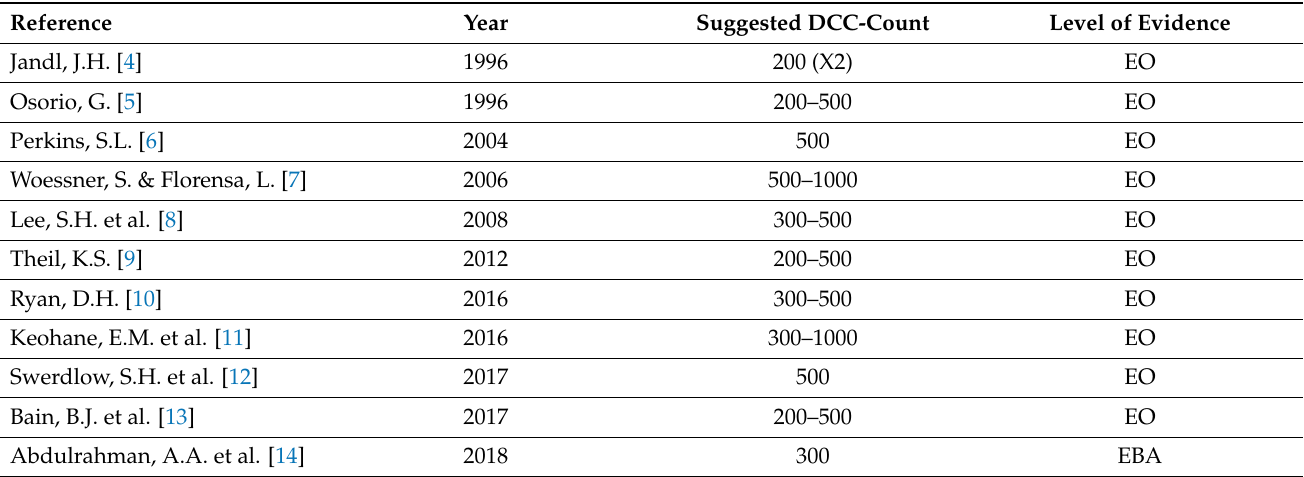
Table 1. Recommendations for bone marrow aspirate differential cell count according with the level of